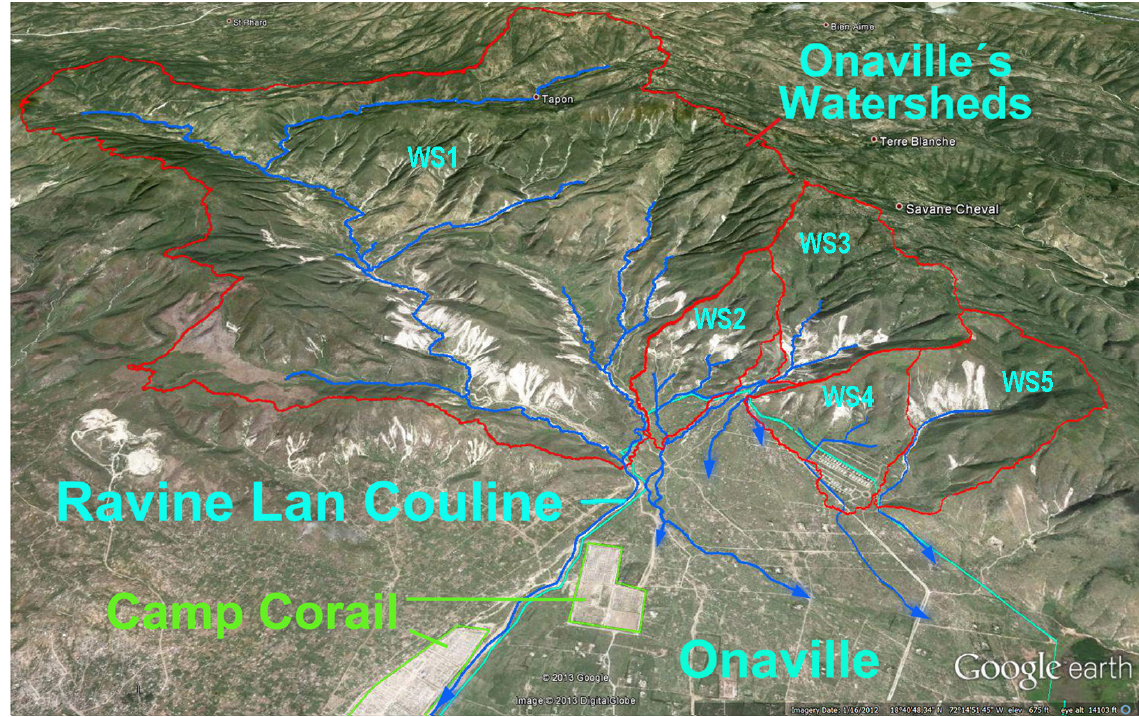
Figure 9. 3D view of the watersheds and drainage courses of Onaville including the watershed of Ravine Lan Couline